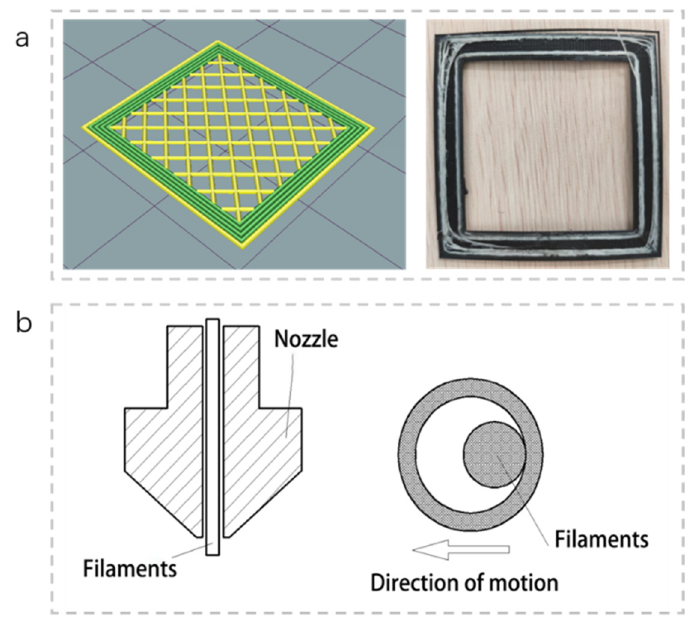
Figure 4. ( a ) Theoretical and practical printing effects of the contour offset method. ( b ) Schematic diagram of CFRF printing.